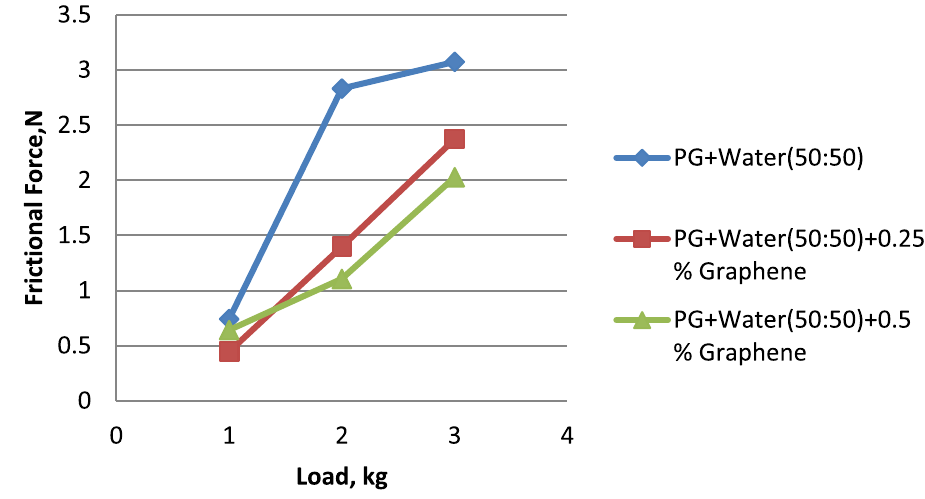
Figure 12. Load vs. frictional force for propylene glycol